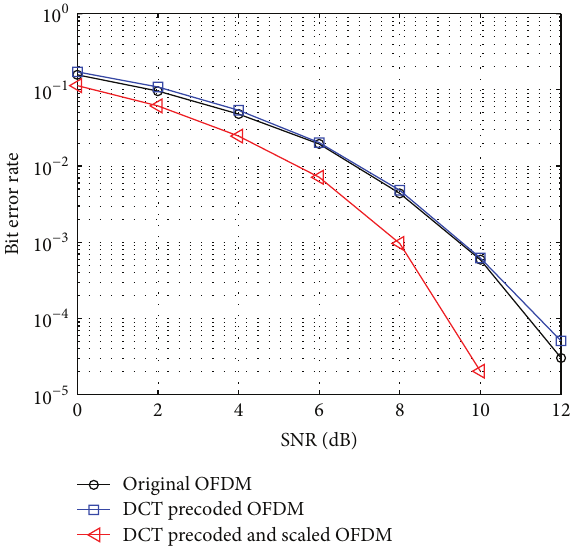
Figure 2: BER performance comparison over AWGN